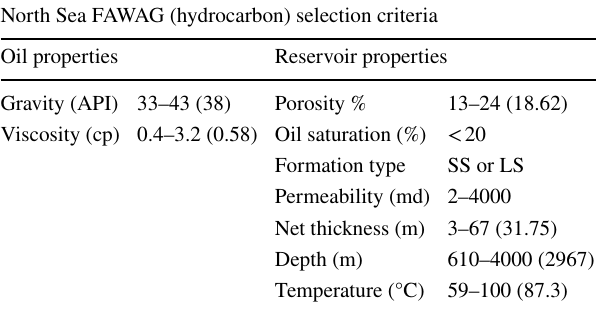
Table 10 North Sea MGI screening criteria North Sea MGI (hydrocarbon) selection criteria Oil